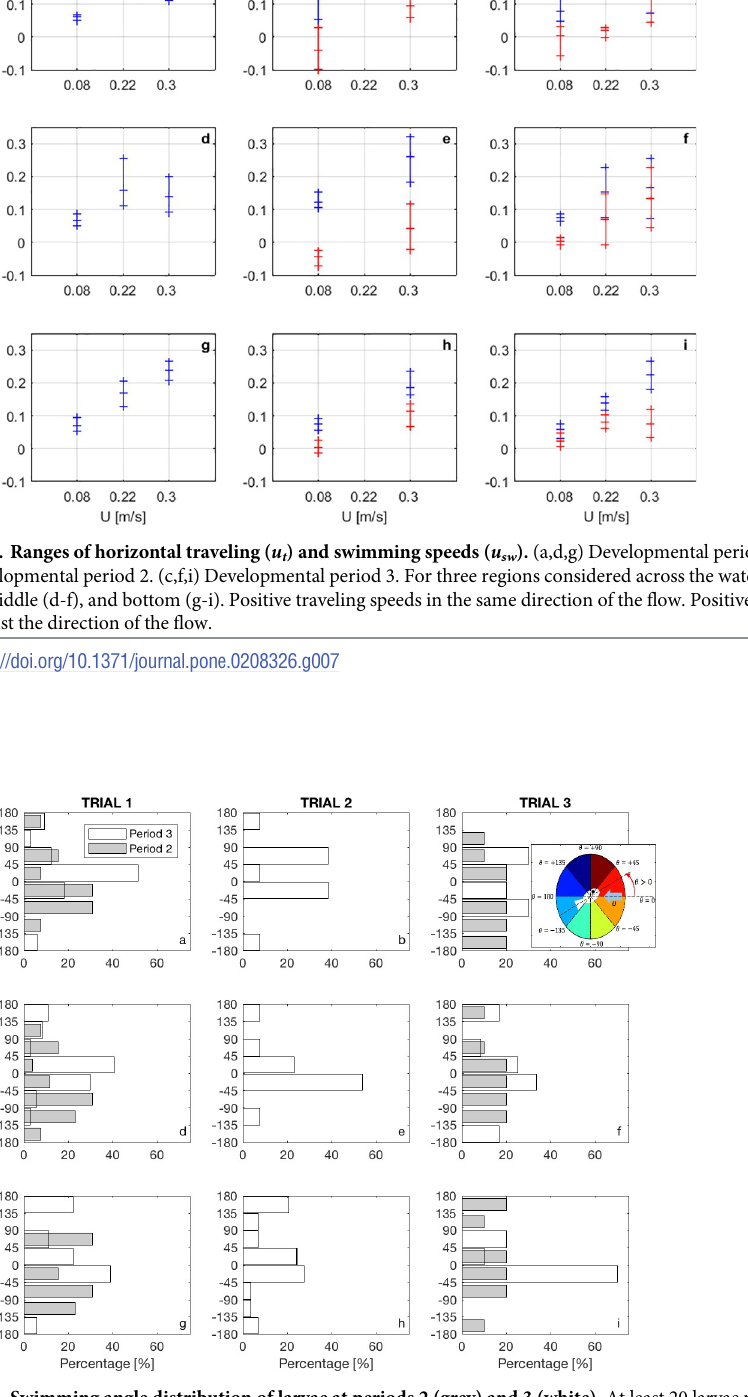
Fig 8. Swimming angle distribution of larvae at periods 2 (grey) and 3 (white). At least 20 larvae per water depth: top (a-c), middle (d-f), and bottom (g-i) were analyzed for each period on trials 1 (a,d,g), 2 (b,e,h), and 3 (c,f,i). Reference frame for swimming angle is indicated in the inset on c